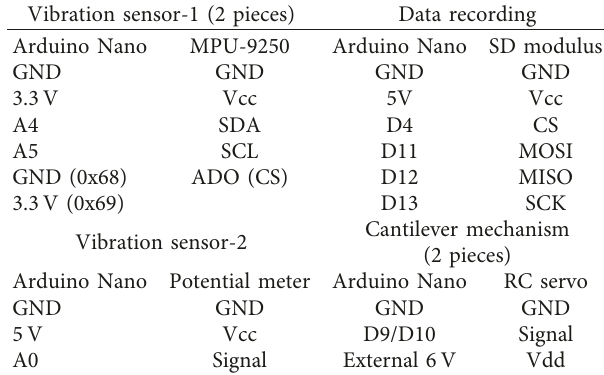
Table 1: Connections of MCU and instruments.